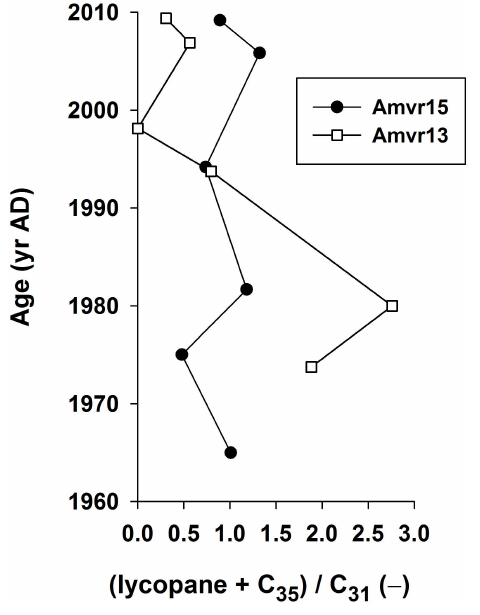
Fig. 7. Profiles of (lycopane + C 35 n -alkane)/C 31 n -alkane ratio vs. age (yrAD).